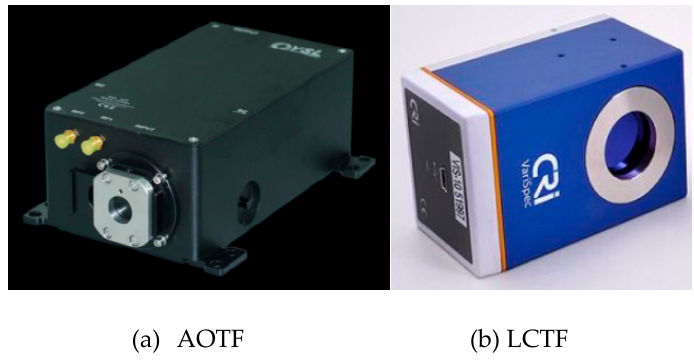
Figure 3. Employed filter device. ( a ) AOTF, ( b ) LCTF